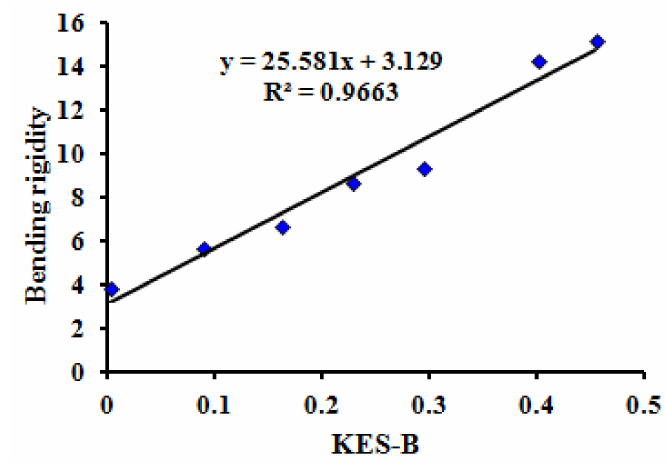
Figure 7. Relationship between bending rigidity ( W BD ) of MTT test and KES bending test.